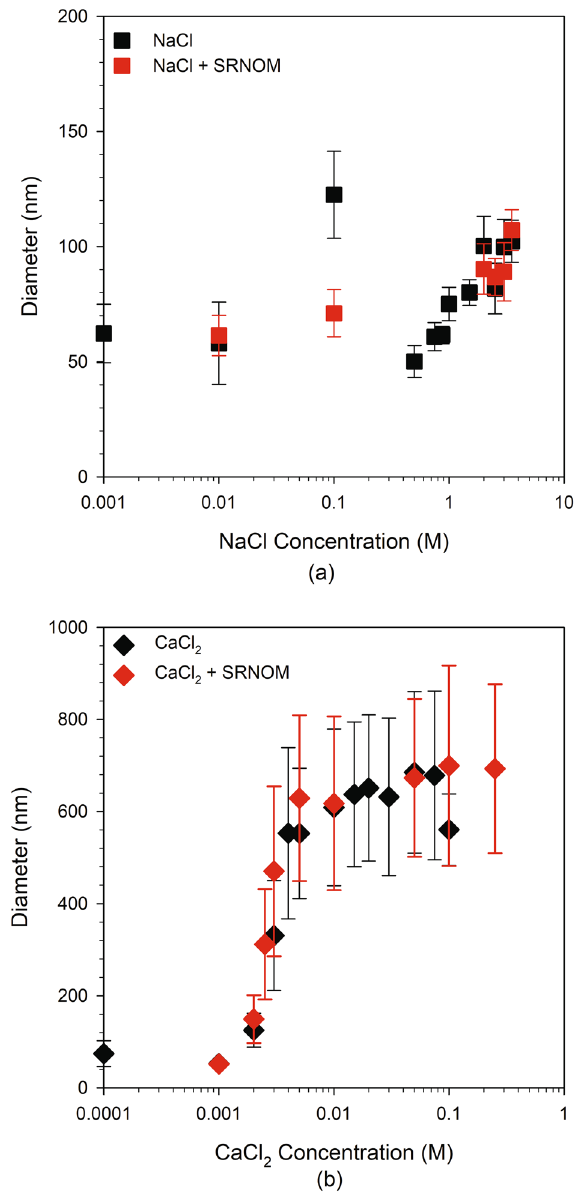
Fig. 2 DLS measurements of the z-average hydrodynamic diameter (z-avg. HD) of QDs suspended in aqueous chloride salt solutions as a function of the types and concentrations of electrolytes and the absence and presence of SRNOM at 10 mg/L: a Monovalent elec- trolyte NaCl in both the absence and presence of the SRNOM at 10 mg/L, b Divalent electrolyte CaCl in both the absence and pres- 2 ence of the SRNOM at 10